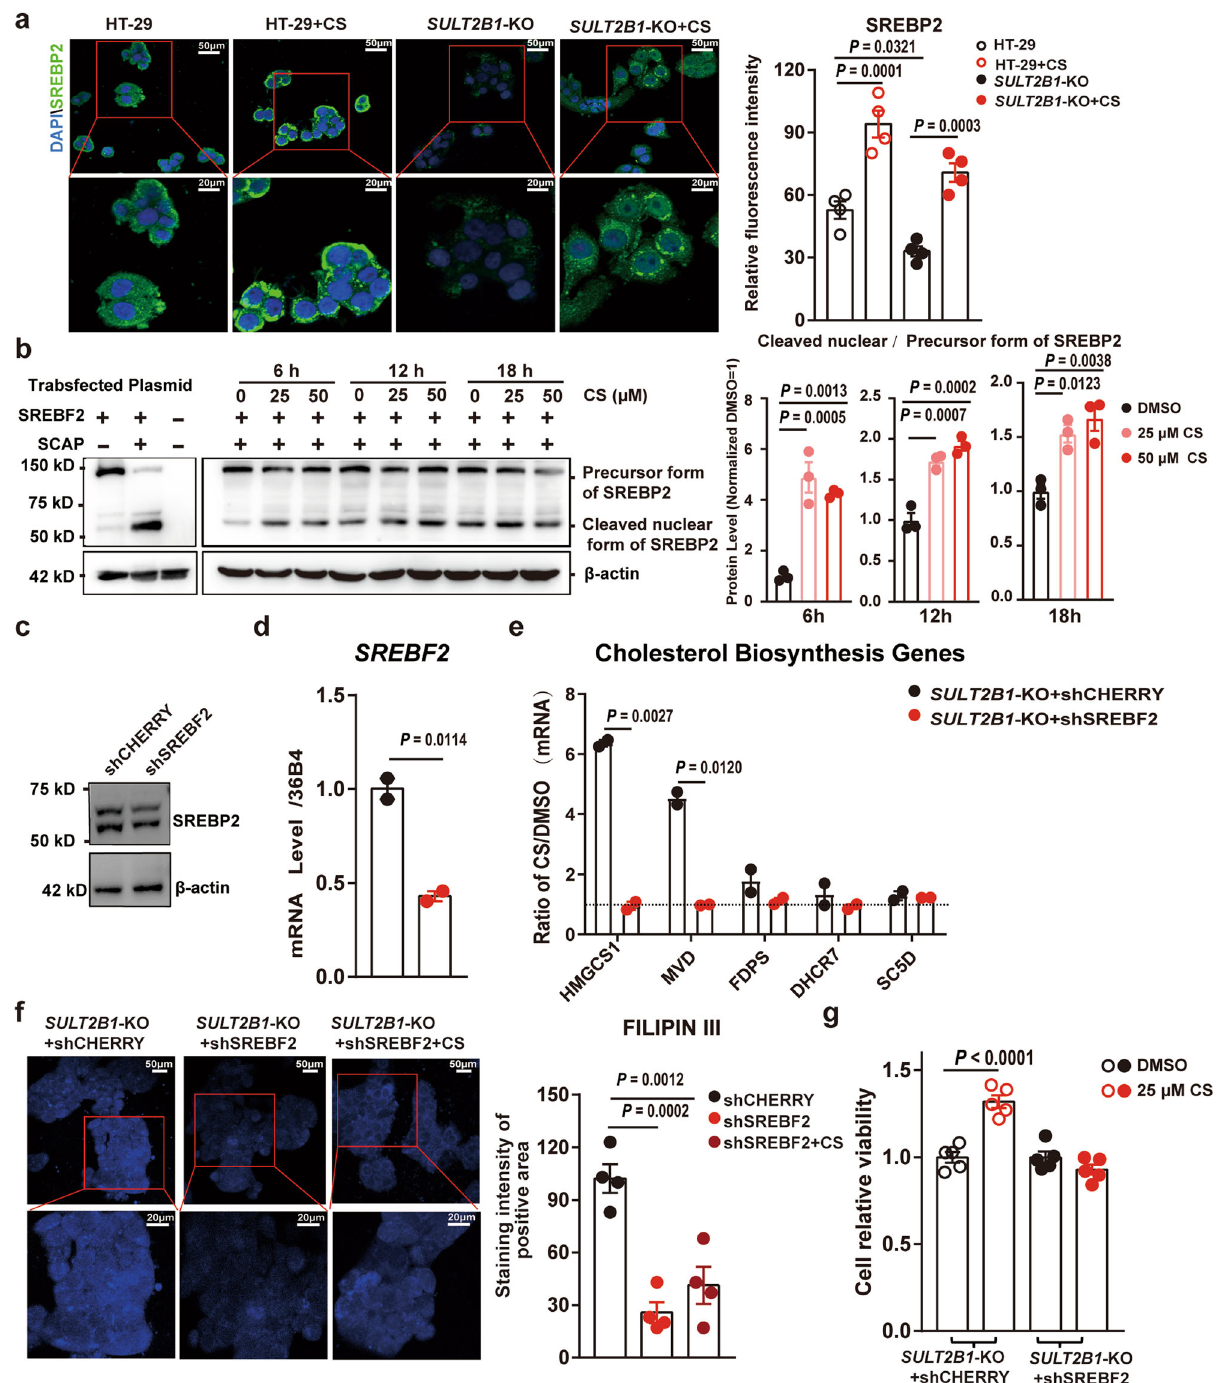
Fig.6|PromotionofcholesterolbiosynthesisbyCSwasdependentonSREBP2. a Immuno fl uorescent staining of SREBP2 in HT-29 and SULT2B1 -KO cells in